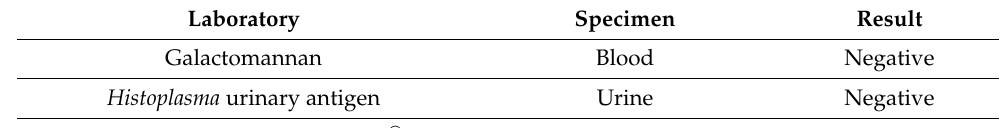
Table 1. Microbiologic